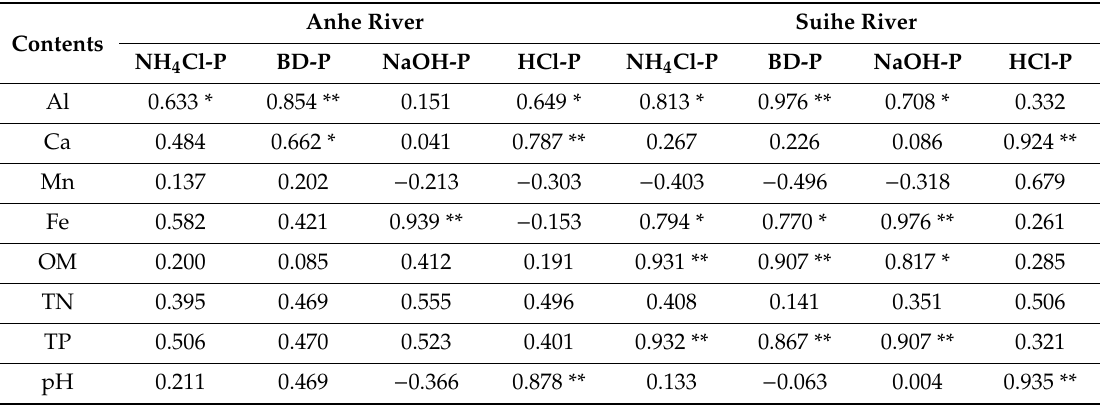
Table 3. Pearson’s correlation coe ffi cient of phosphorus fractions of sediments in Hongze watershed.